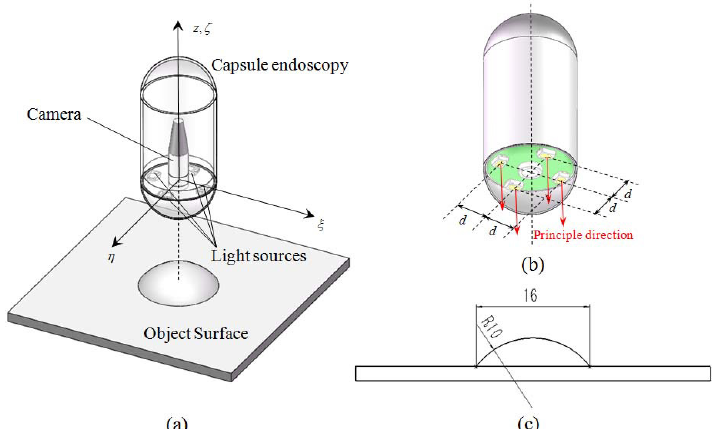
Figure 7. Simulation configuration of photometric stereo in monocular capsule endoscopy. ( a ) General view of the simulation environment. ( b ) Camera and light sources’ distribution in the photometric stereo frame (where d is the distance from the camera to each light source). ( c ) Section view of the object surface (dimensions in